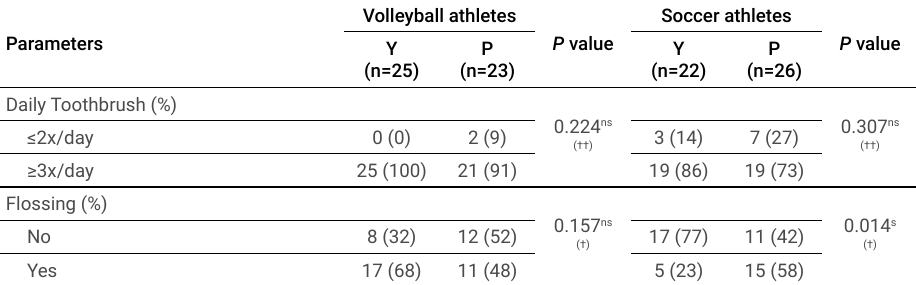
Table 1. Oral hygiene habits, oral health conditions and athletes’ perception about the influence of oral health conditions on the physical performance of youth (Y) and professional (P) volleyball and soccer athletes (Ponta Grossa, Paraná, Brazil, 2018 to